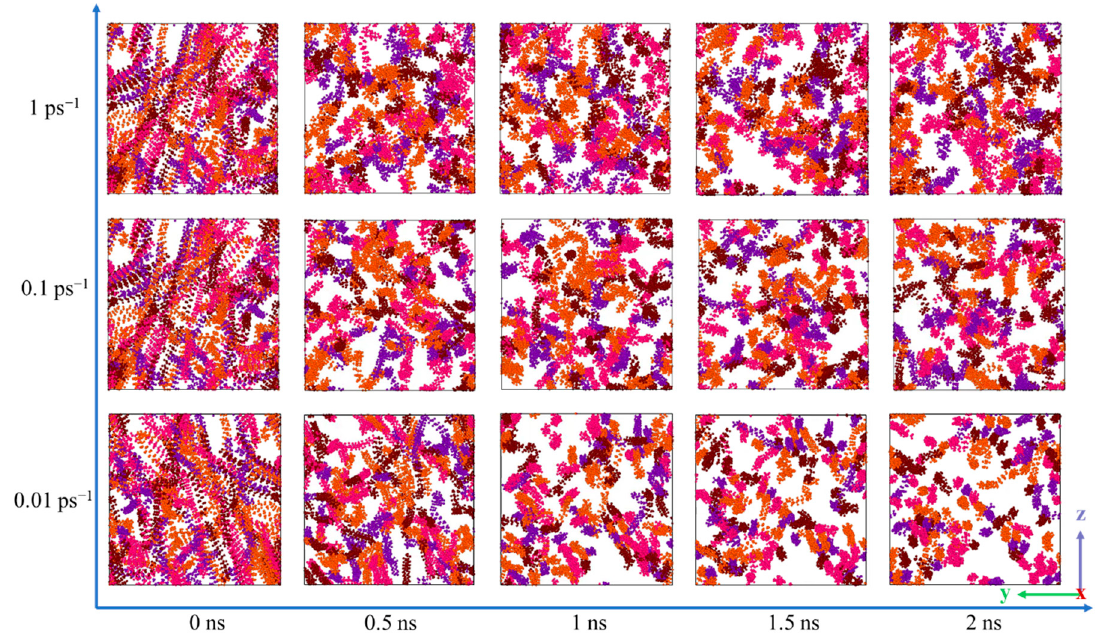
Figure 8. Arrangement of wax molecules in the yz direction at different shear rates at 293.15 K.